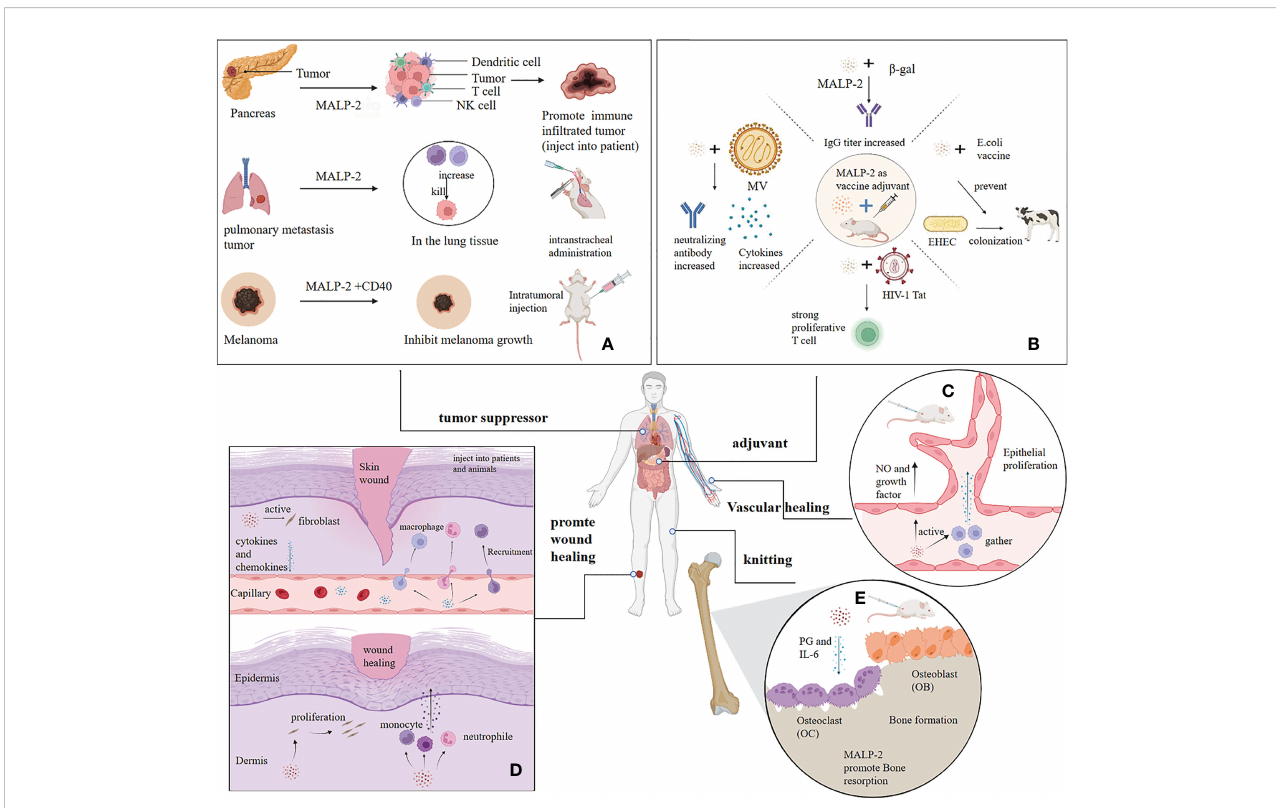
FIGURE 3 Application of MALP-2. (A) MALP-2 inhibited the growth of pancreatic cancer tissue in patients and prevented lung metastases in mice, and MALP-2, combined with CD40, signi fi cantly suppressed melanoma growth in mice. (B) MALP-2 can enhance the immune response and act as an adjuvant when used with various vaccines. (C) MALP-2 recruited macrophages to release cytokines to induce vascular endothelial cell proliferation and promote angiogenesis; MALP-2 stimulated endothelial cells to release NO and cytokines. (D) MALP-2 stimulates skin fi broblasts to release cytokines and chemokines, thereby recruiting granulocytes, monocytes, and macrophages to the wound; MALP-2 induces fi broblasts to proliferate and stimulates recruited immune cells to release growth factors for wound healing. (E) MALP-2 increases bone resorption activity of osteoclasts by inducing the release of PGE and IL-6, which in turn accelerates bone healing in